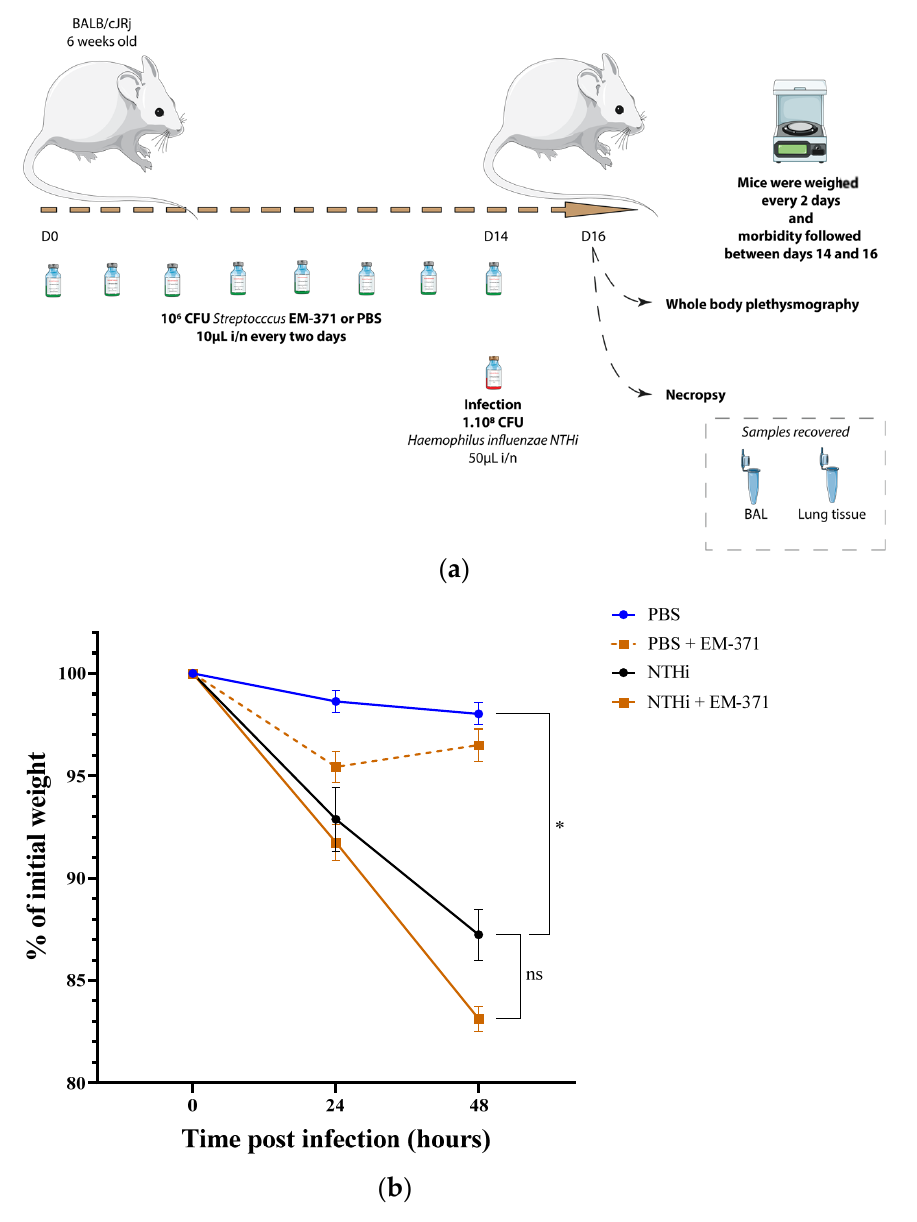
Figure 2. Streptococcus EM-371 did not protect against weight loss. ( a ) Experimental procedure to induce Haemophilus influenzae lung infection. ( b ) Mice were weighed daily. The growth curves are expressed as the mean ± s.e.m. of individual weights. To determine the statistical difference, the area under the curve was calculated and one-way ANOVA using Tukey’s multiple comparisons test was performed with GraphPad version 8. p -values: *: p < 0.03.